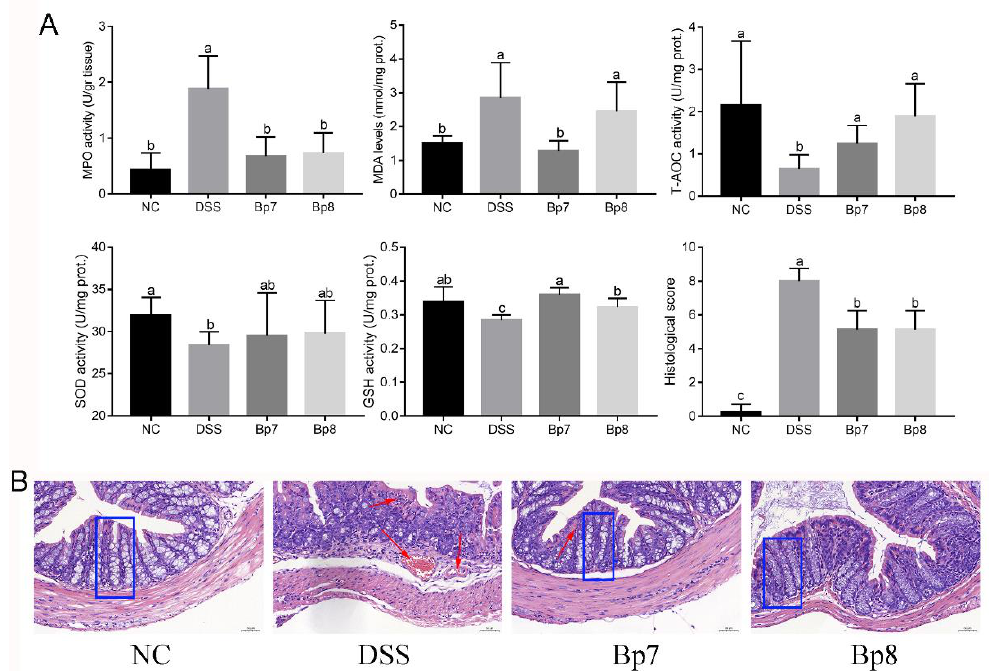
Figure 3. Influence of Bp7 and Bp8 intervention on the activity of antioxidant-related parameters and the histological injury in the colon. The activities of MPO, MDA, T-AOC, SOD, GSH and histological score ( n = 8) ( A ); Histological analysis of colon tissue (the red arrows show inflammatory cell infiltration; blue frame show crypts) ( B ). The different letters represent significant differences between experimental groups ( p < 0.05).